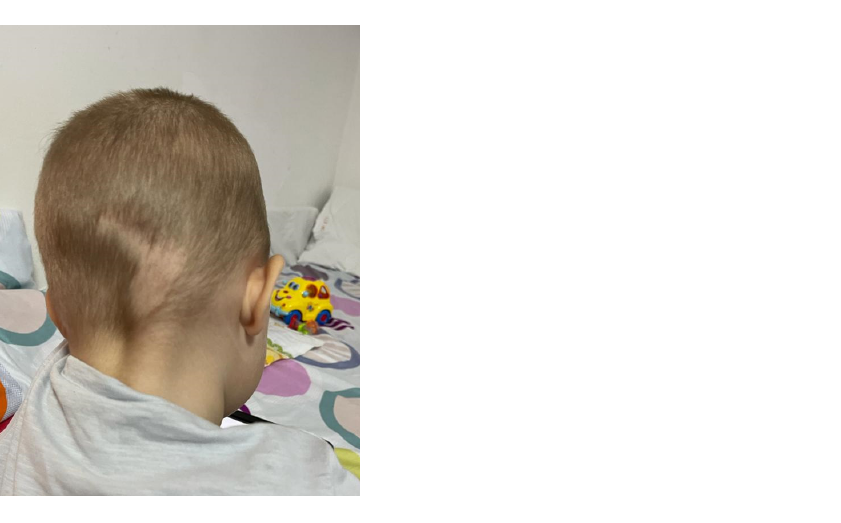
Figure 6. Electrocardiogram after thrombolysis, criteria of reperfusion.